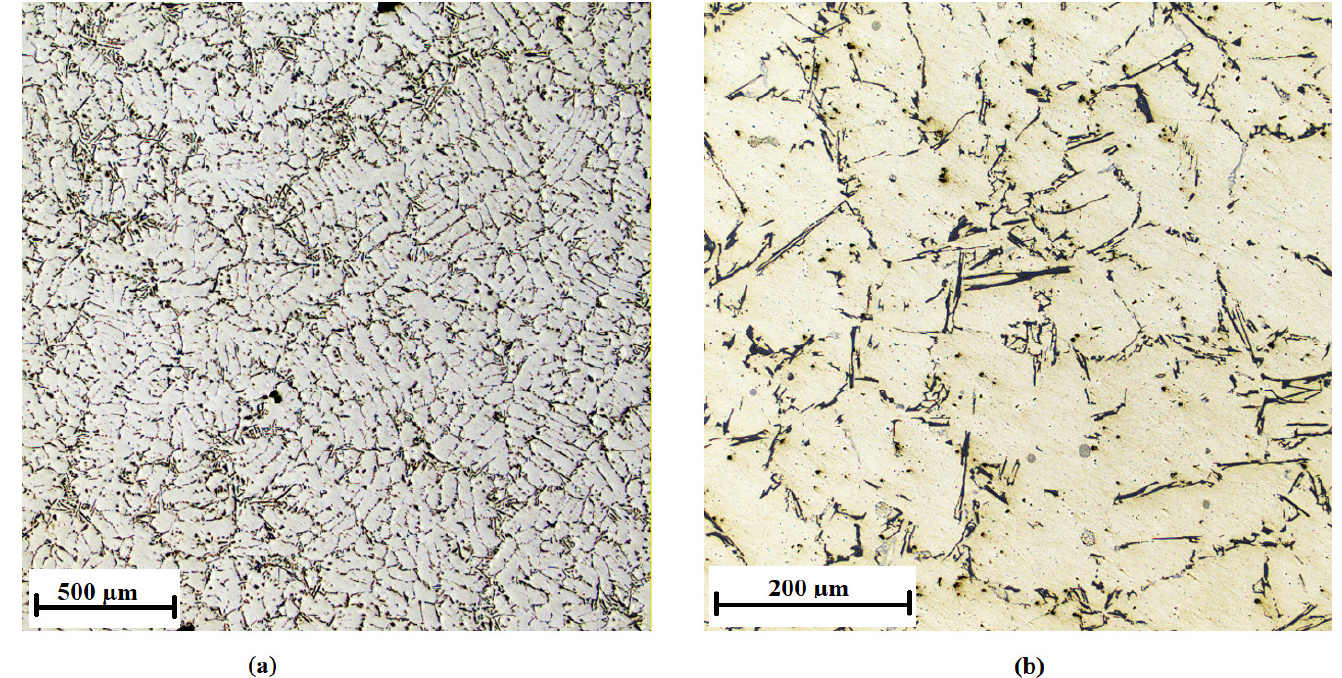
Figure 10. Microstructure of the AlSi7Mg0.3 alloy without inoculants: ( a ) low-magnification overview, ( b ) detail.